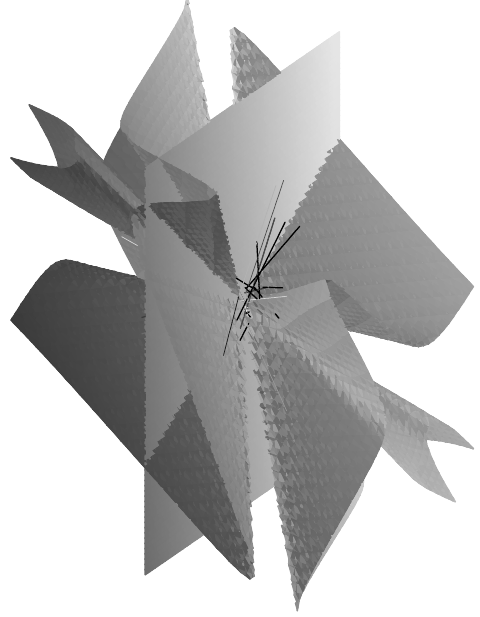
Figure 5.1 . The quartic surface for d = 30 . 00 at ( − 54 , 68 )